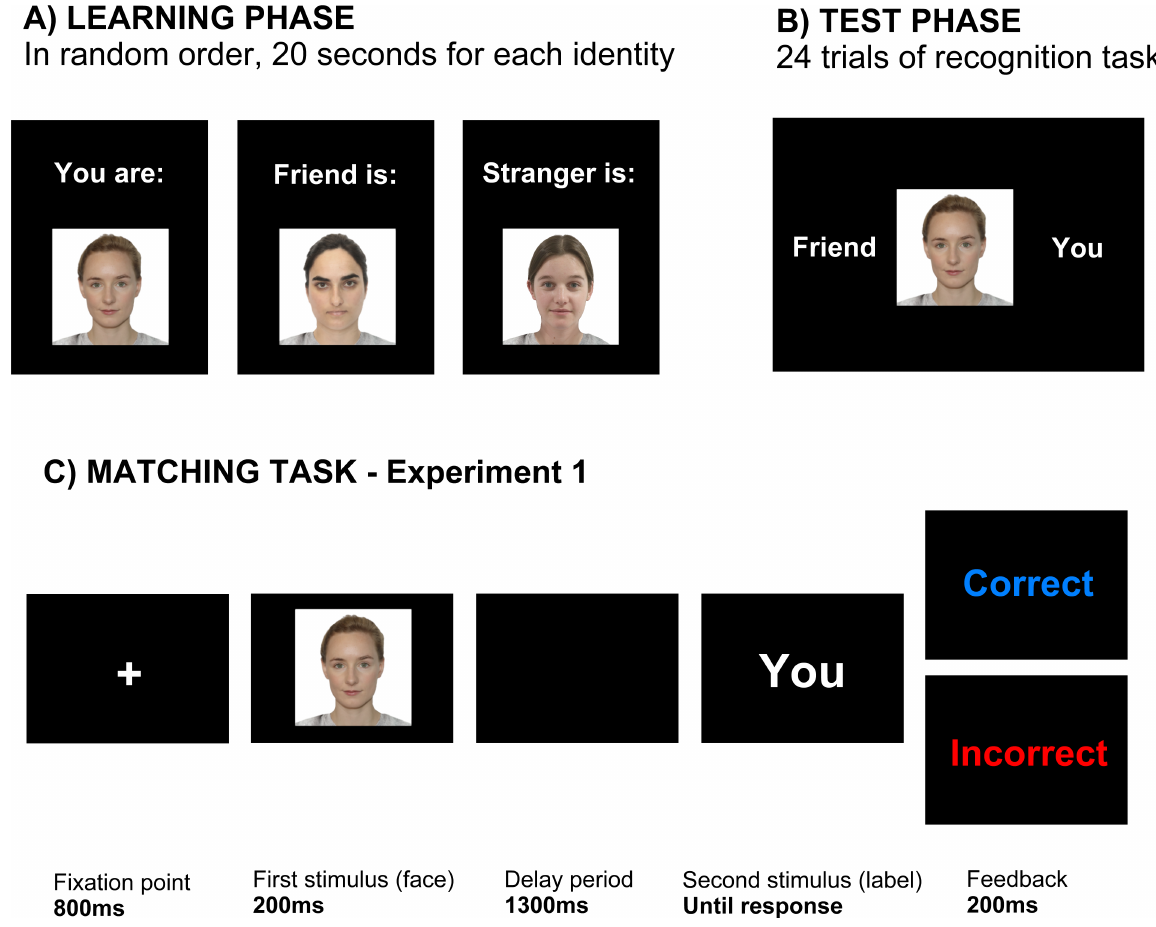
Fig 1. The procedure of experiment 1. (A) Participants started with the learningphase duringwhich they were presented with three faces together with their identities. The faces were presented sequentially in random order for 20 seconds each. (B) Followingthe learningphase, participantscompleteda test assessing whetherthey had learnedto correctly assign labels to faces. In this test they were asked to choose which of two labelscorrespondedto a particularface. (C) The main task was a matchingtask duringwhich EEG was recorded. Each trial started with a fixation cross followedby a short presentation of a face. After 1300ms of a delay perioda label was displayedand stayed on the screen until the participant responded.The photographsare for illustrationpurposes, they were not the faces used in the task. The individuals from the photographshave given written informed consent (as outlined in PLOS consent form) to publishthese photographs.